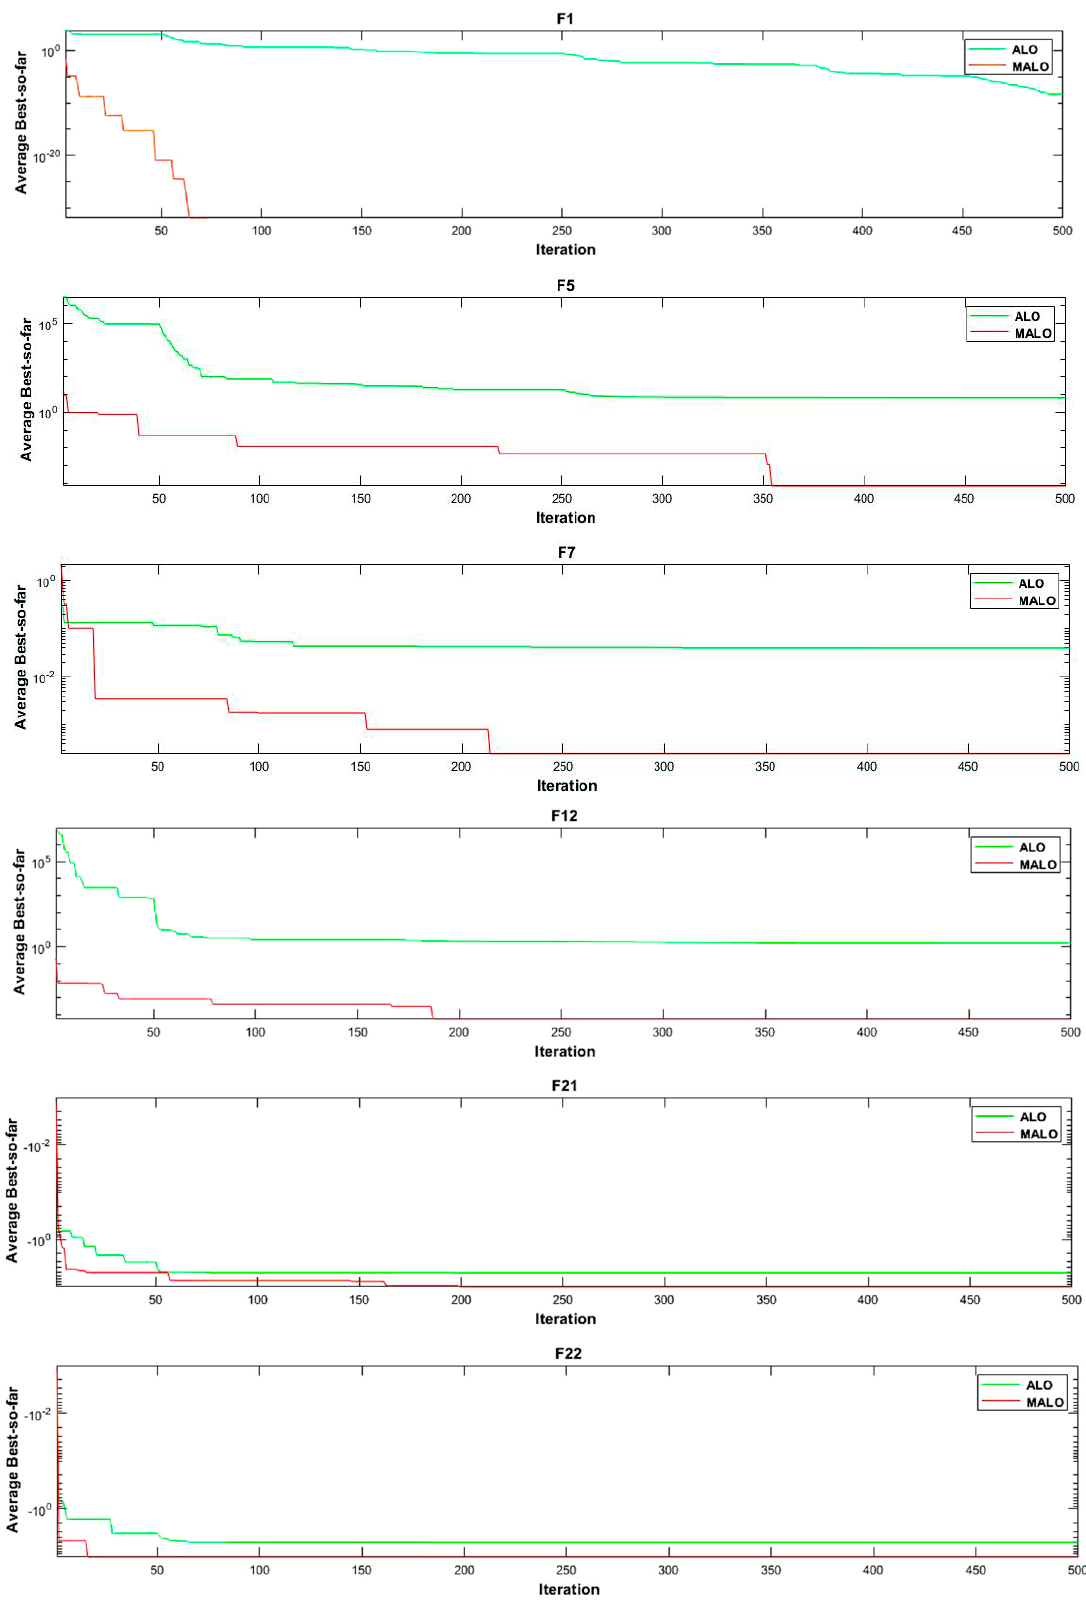
Figure 4. Convergence curves of ALO and MALO on six of the benchmark functions (500 itera- tions).